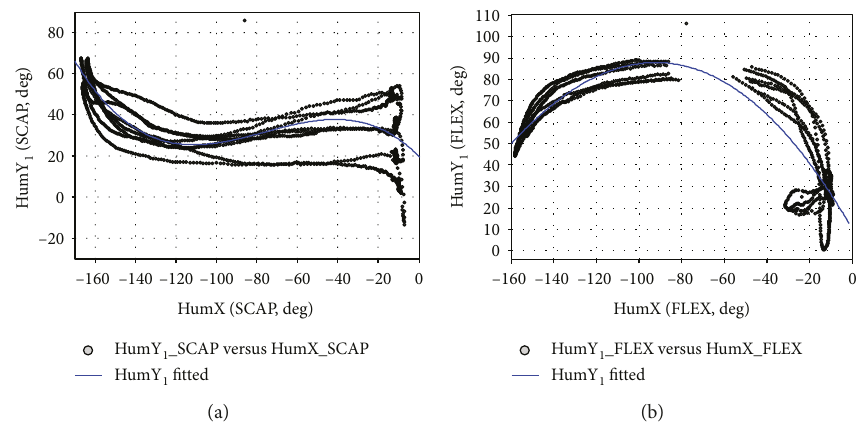
Figure 22: The ranges of plane of elevation when the movement of SCAP and FLEX is exerted. shoulder bones and the axial rotation angle HumY Table 8: The ranges of plane of elevation. humerus is not signi fi cant. At the same time, axial rotation Type of exercise ABD SCAP FLEX ° ~20 Range of plane of elevation − 10